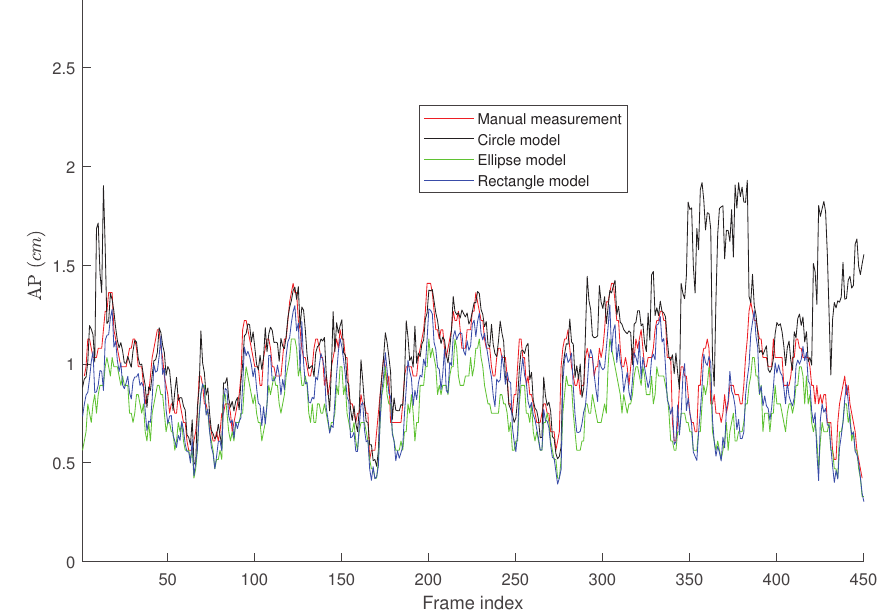
Figure 8. AP-diameter for the third sample video depicted in Figure 5, as measured by the manual measurement (red line), active circle algorithm (black line), active ellipse algorithm (green line) and active rectangle algorithm (blue